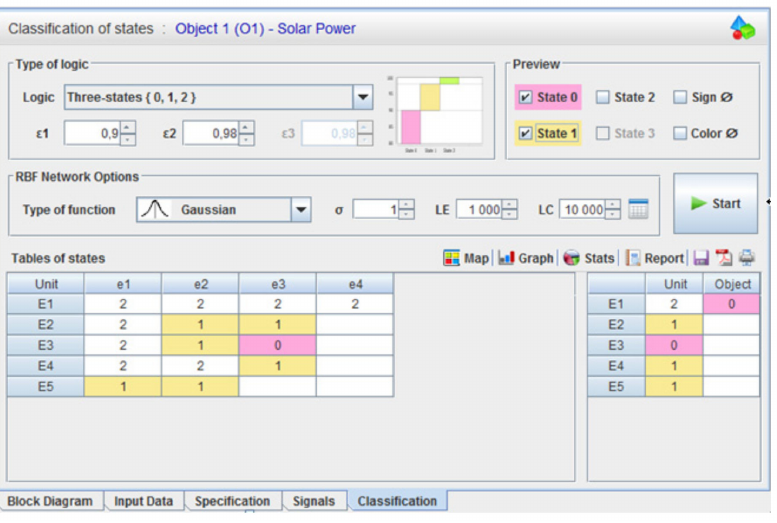
Figure 11. The resulting form of the DIAG 2 program “Table of states of L-PSPD” for 3VL.